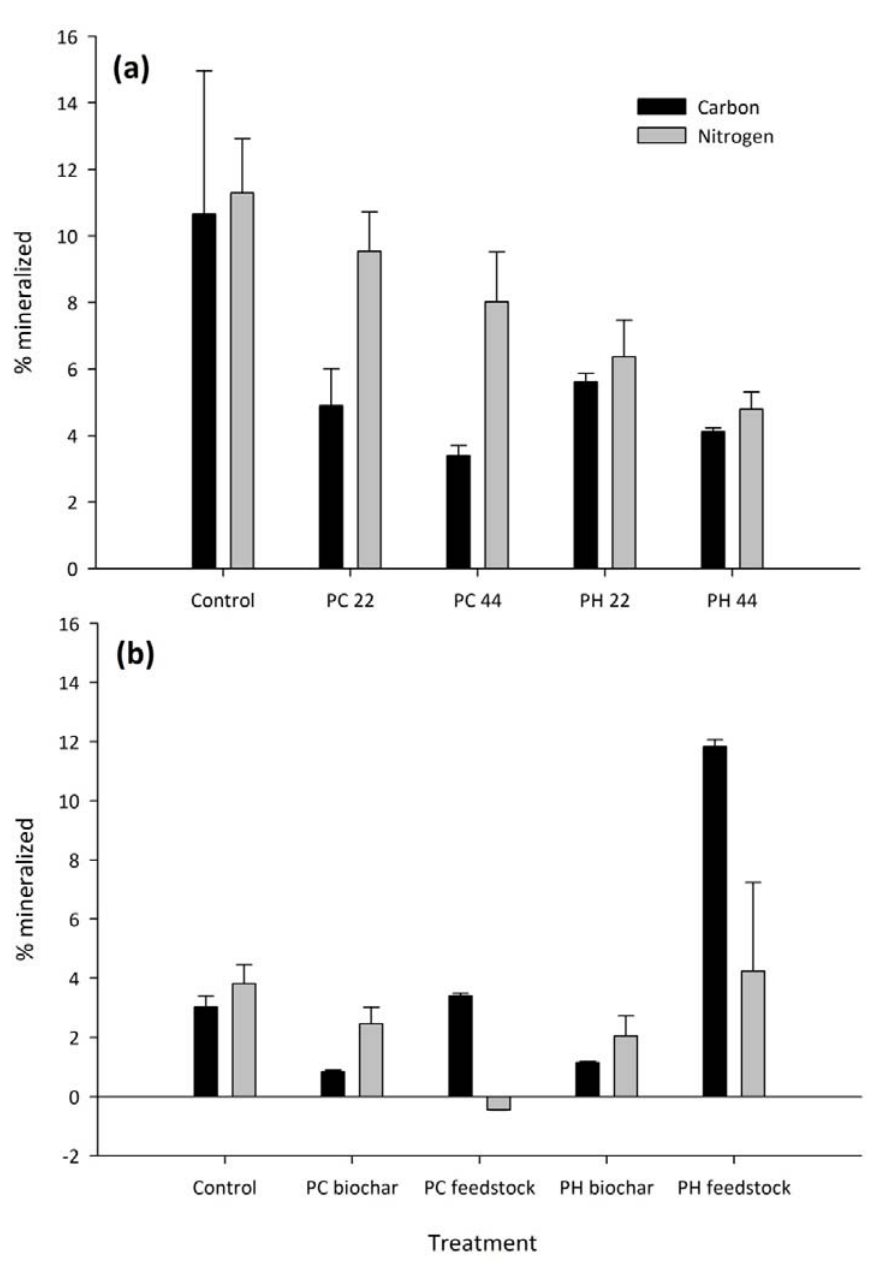
Figure 4. Net mineralization of total C and N, with standard deviation, from each treatment of the ( a ) 136-day and ( b ) 24-day mineralization